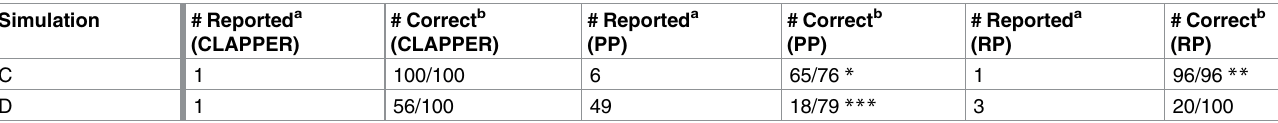
Table 1. Accuracyfor estimating the true